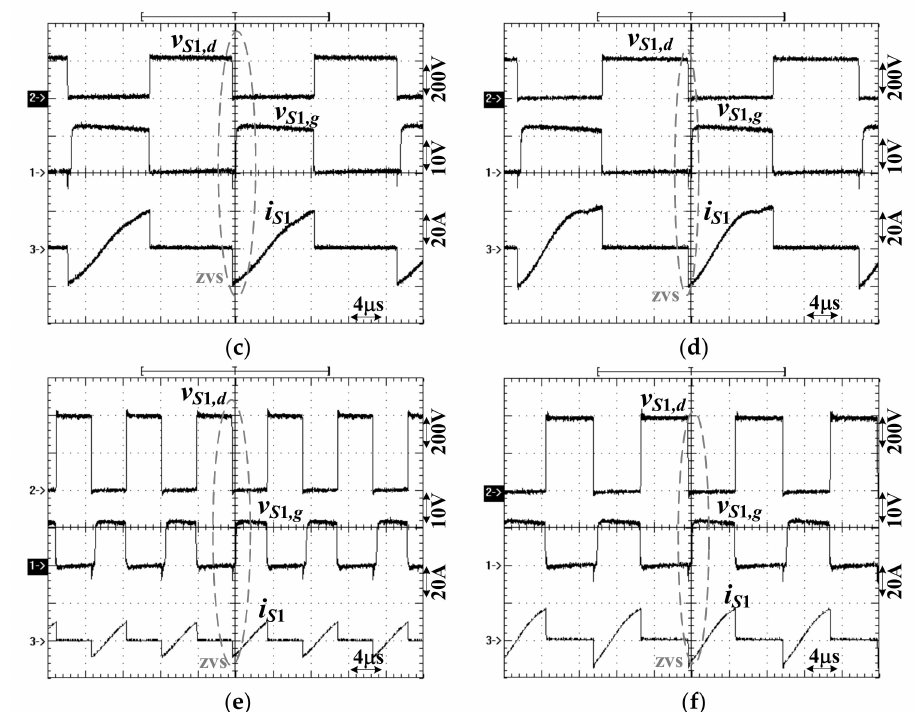
Figure 10. Experimental results of PWM signals for high input voltage region: ( a ) S 1 – S 4 at 210 V input and 100% power; ( b ) S 1 – S 4 at 400 V input and 100% power; ( c ) S 1 voltage and current at 210 V input and 20% power; ( d ) S 1 voltage and current at V in = 210 V input and 100% power; ( e ) S 1 voltage and current at 400 V input and 20% power; ( f ) S 1 voltage and current at 400 V input and 100% power.